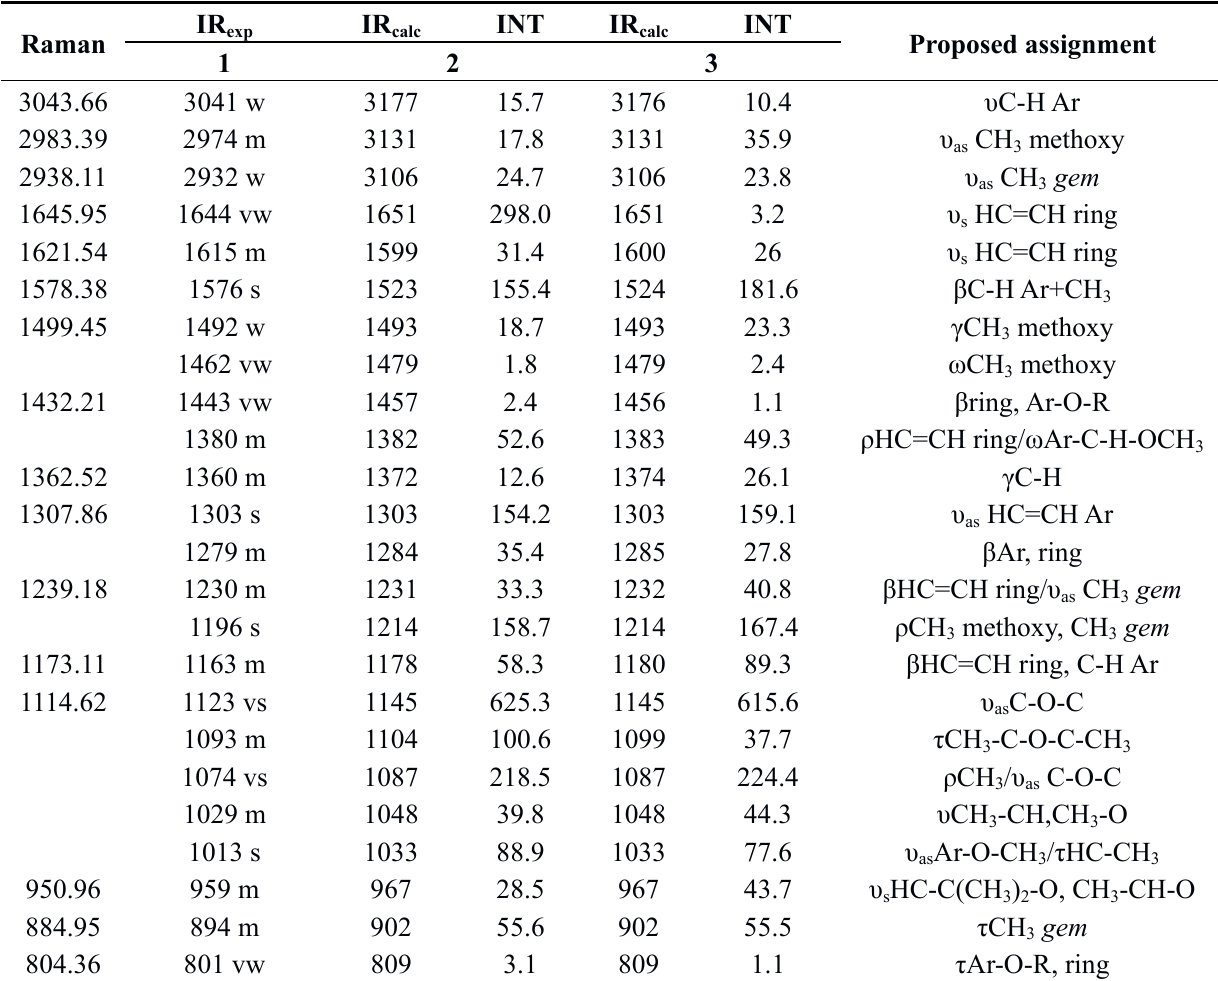
Table 3. Experimental and calculated (B3LYP/6-311G(d,p)) vibrational frequencies of ( − )-encecanescin ( 1